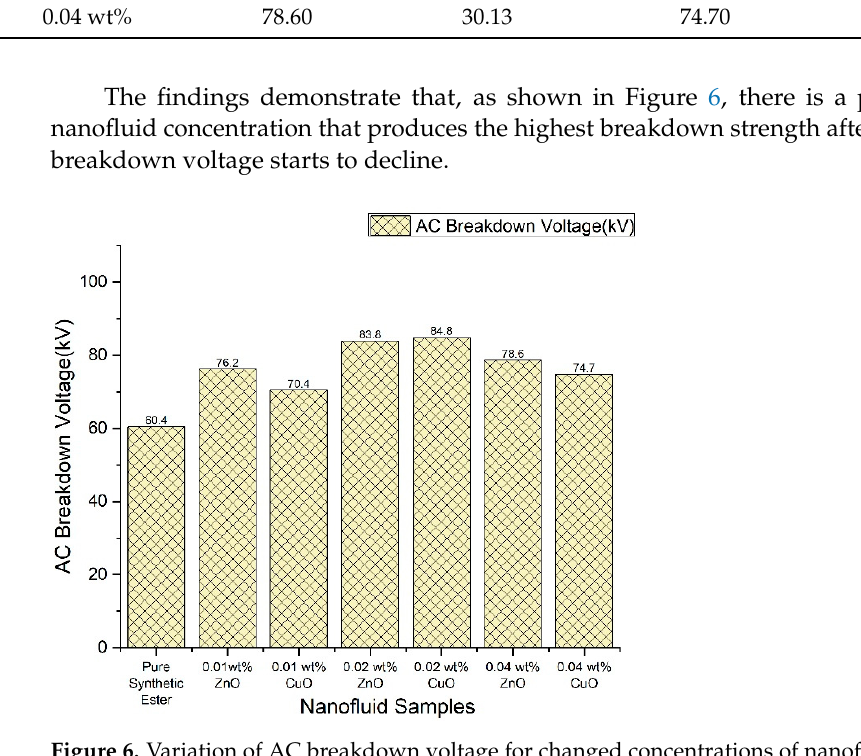
Figure 6. Variation of AC breakdown voltage for changed concentrations of nanofluids.